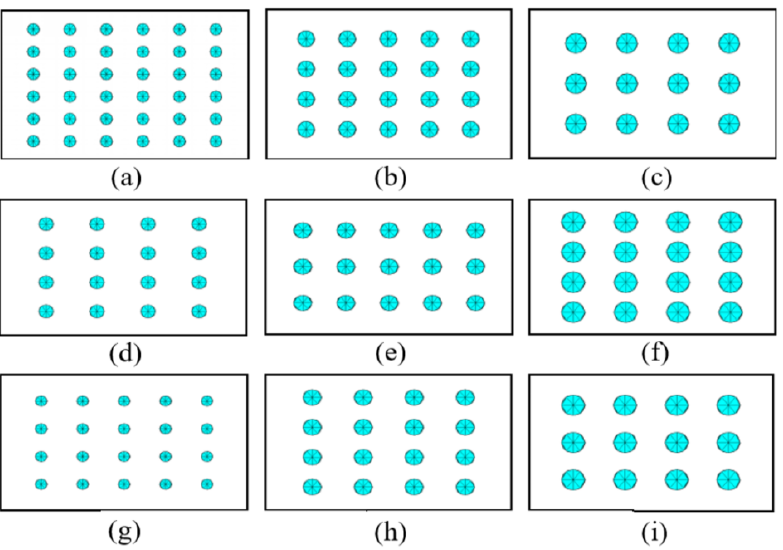
10 of 22 Table 3. Nine optimization schemes for orthogonal design. Factor Scheme